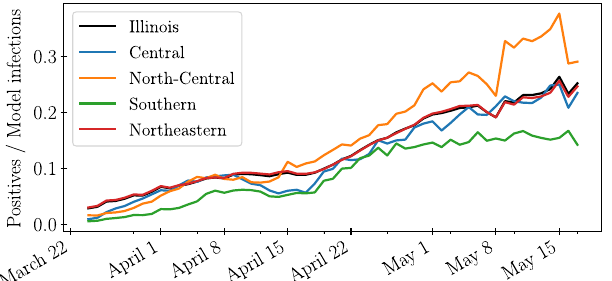
the prior on IFR, which we do not calibrate and instead draw from the